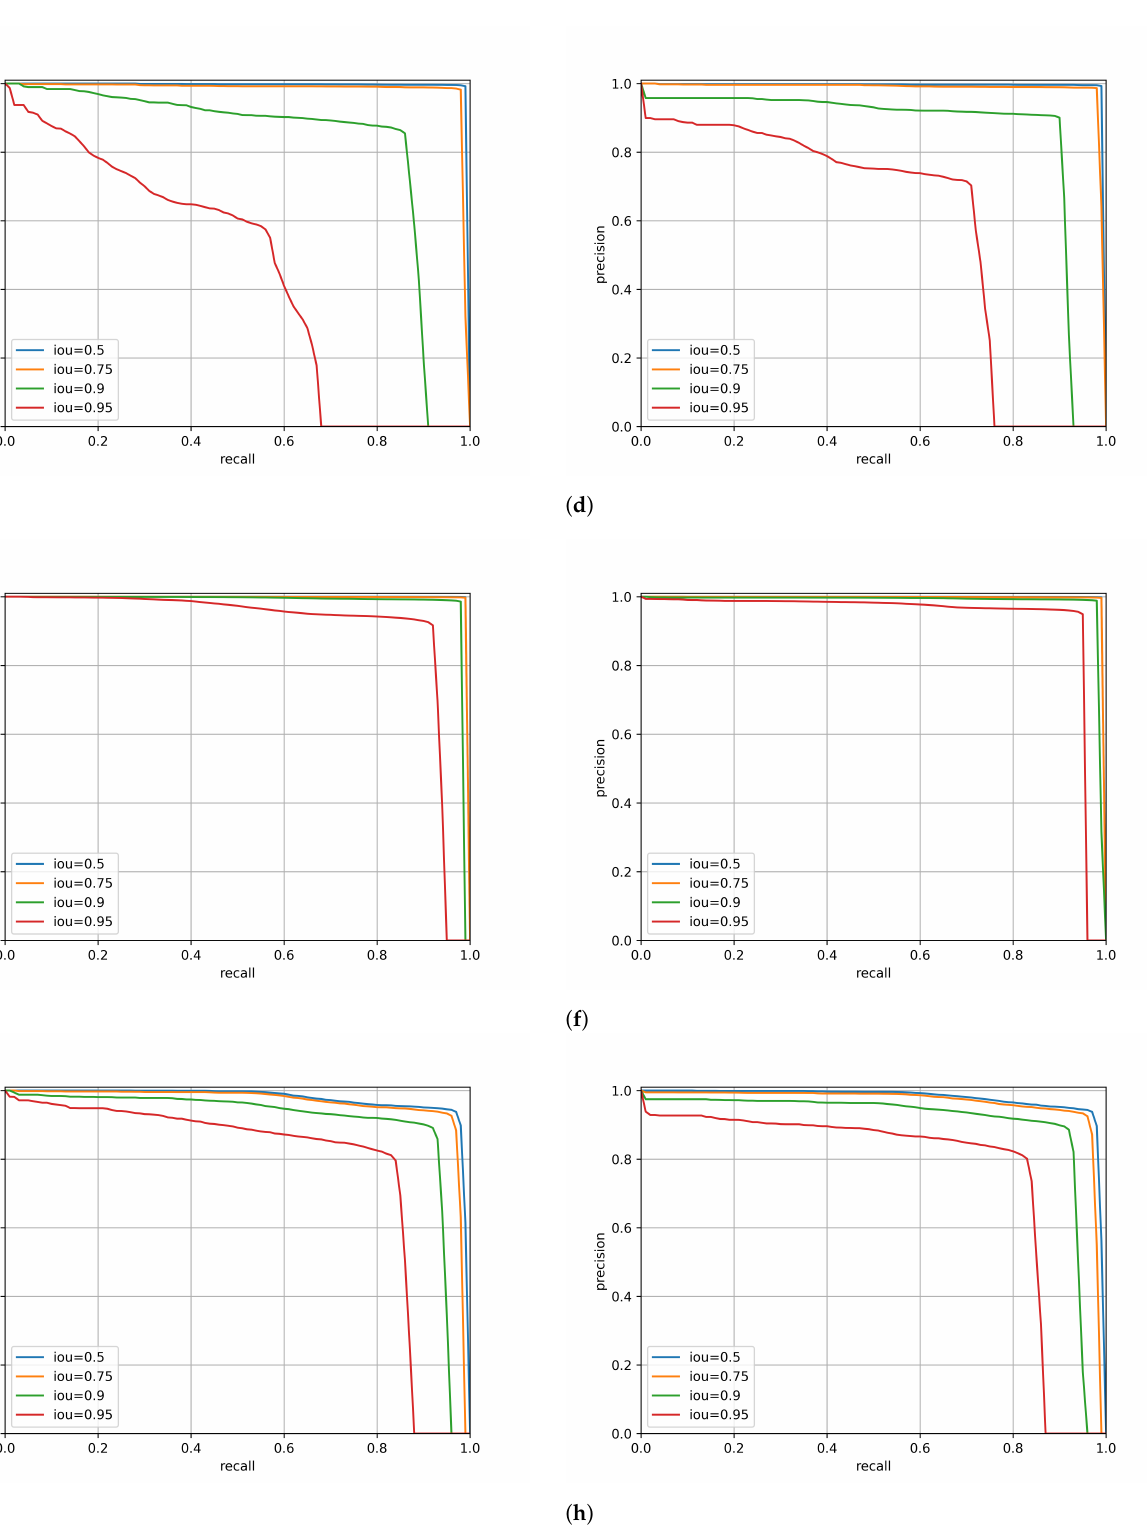
Figure 5. Precision–recall (PR) curves for FT ( a , c , e , g ) and ER ( b , d , f , h ) with Sparse R-CNN on four datasets. Each row corresponds to a dataset (from top to bottom): TableBank, PubLayNet, PubTables- 1M, FinTabNet. Different IOU threshold are demonstrated with blue, orange, green, and red which correspond to 50%, 75%, 90%, and 95%,